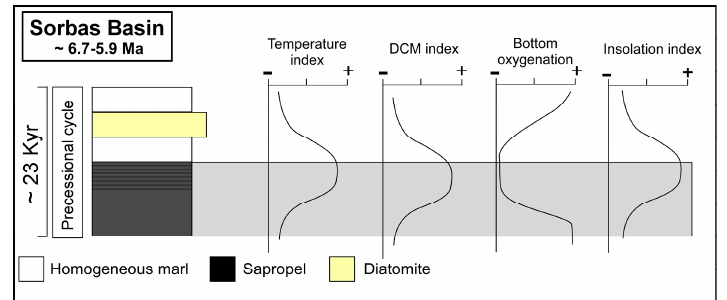
Figure 4. Sketch showing the micropaleontological feature characterising the cyclical sapropel deposition during the Messinian (from 6.7 to 5.9 Ma) in the Sorbas Basin. Data from [46,49,60,61], summarized by [20]. More details in the Section 4.1.